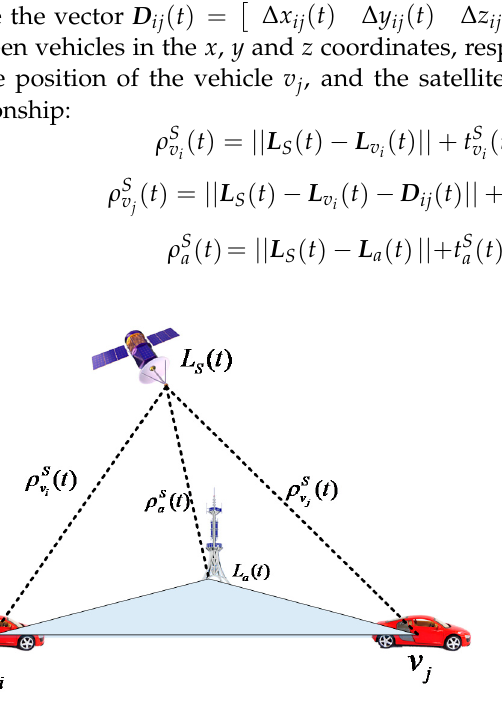
Figure 3. Pseudoranges differencing distance.